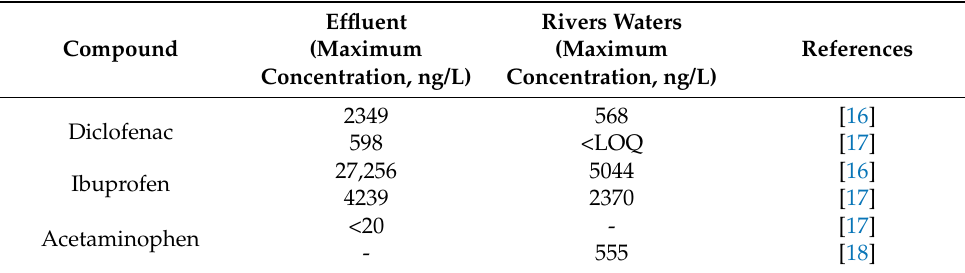
Table 1. Concentrations of diclofenac, ibuprofen, and acetaminophen in the environment. Effluent Rivers Waters Compound (Maximum Concentration, ng/L)